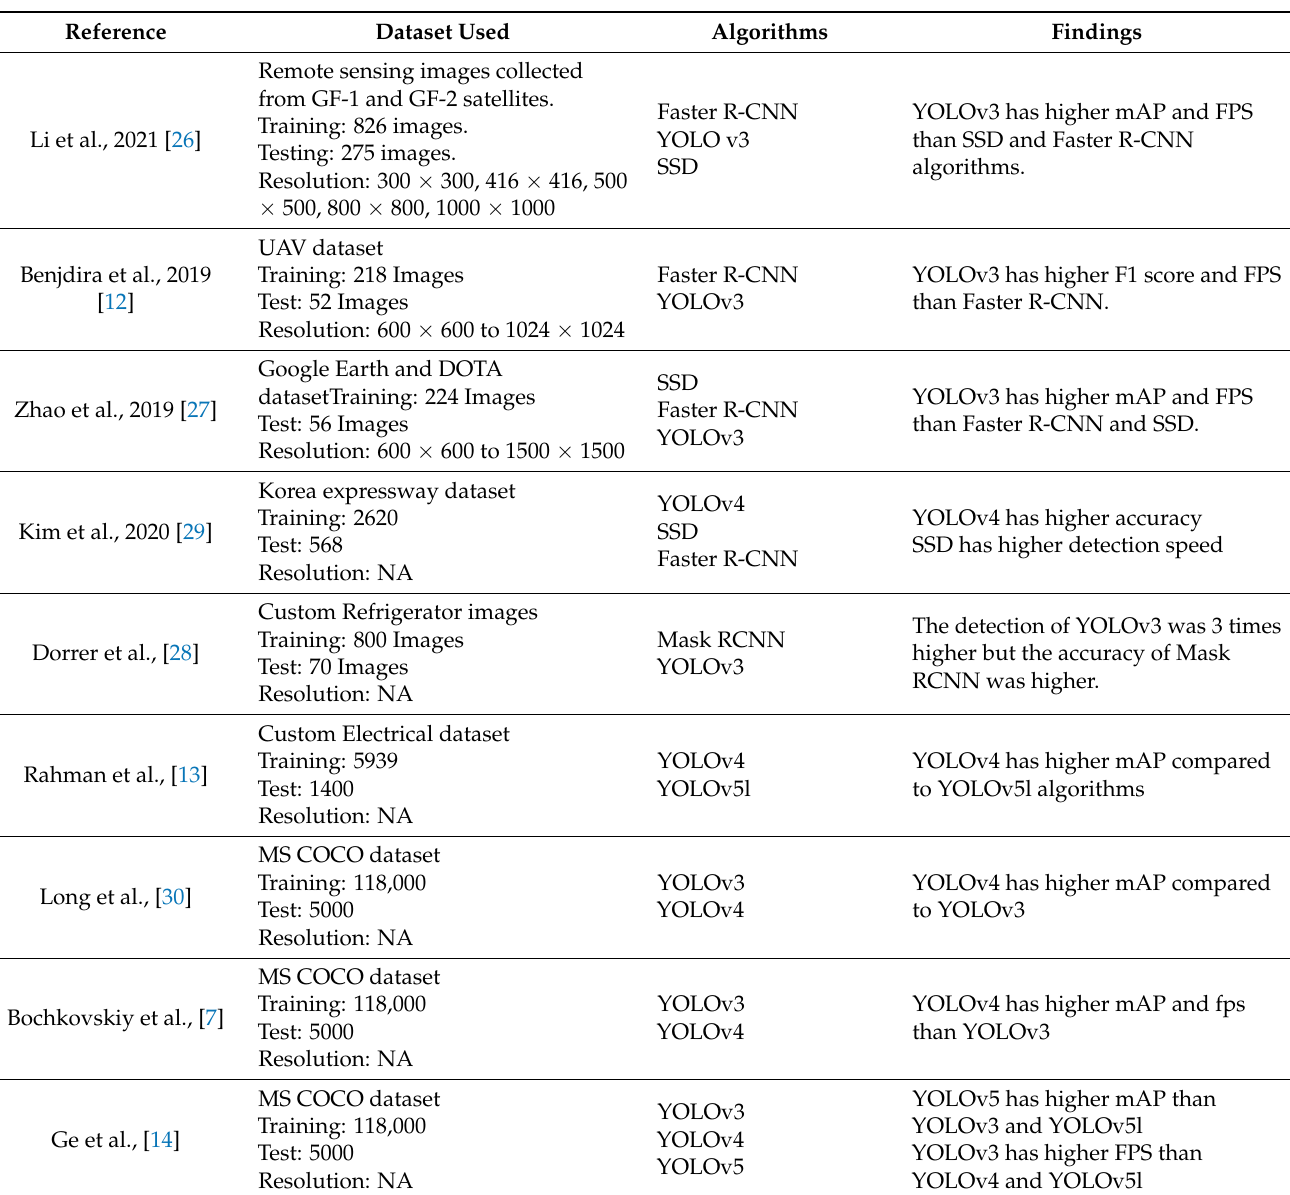
Table 1. Comparison of YOLO with related